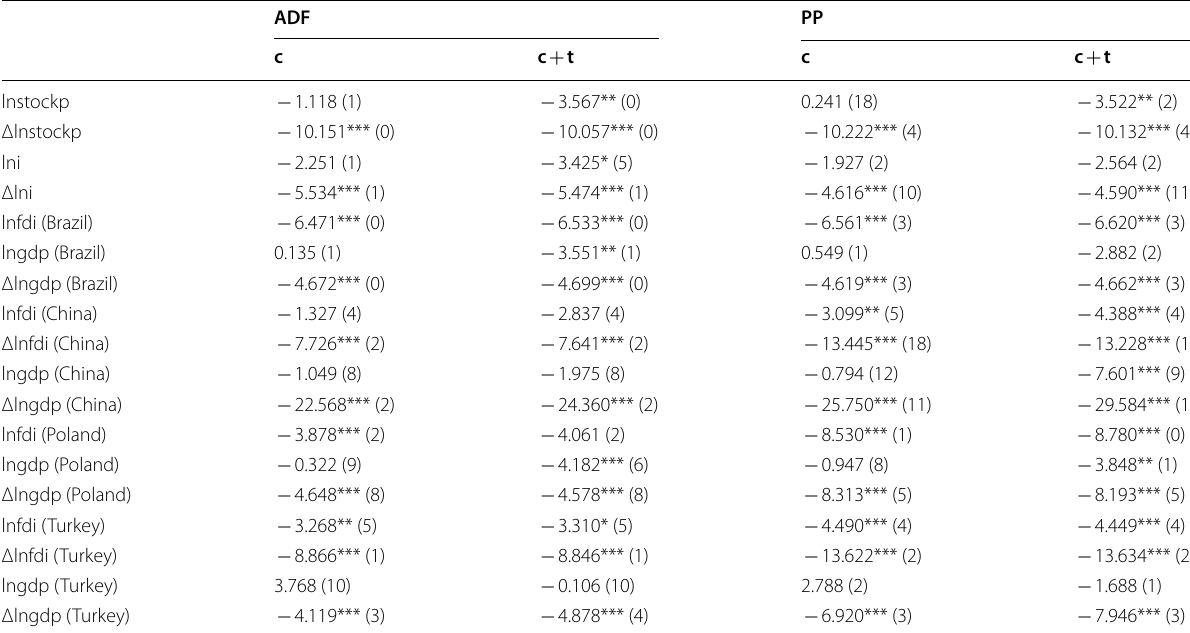
Table 2 ADF and PP unit root